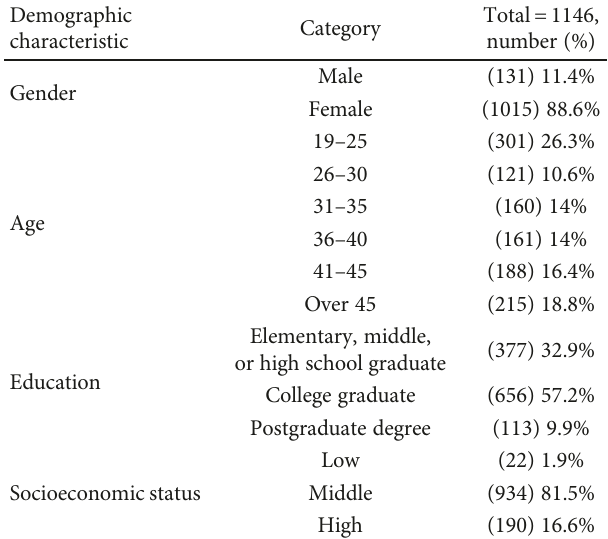
Table 1: Demographic characteristics of the population